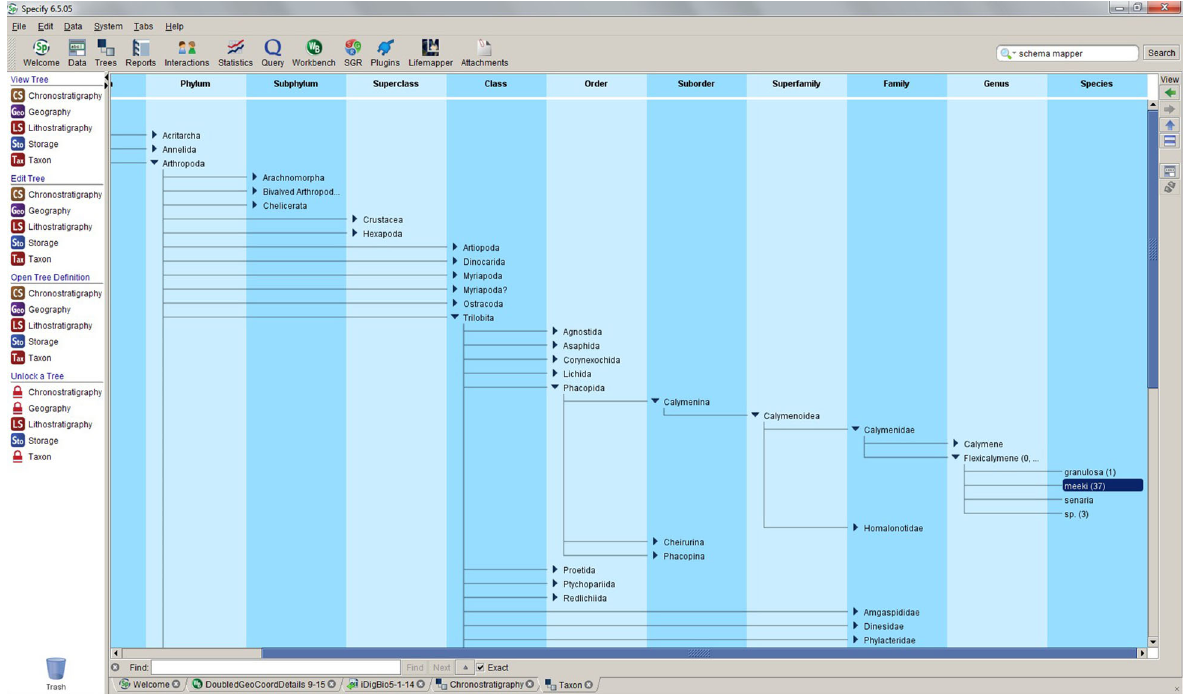
Fig. 2. Screen shot from Specify 6.5 illustrating the hierarchical taxonomic structure on which the database schema is constructed. This view illustrates the taxonomic relationship of Flexicalymene meeki . Locality and stratigraphic data are stored in similar hierarchical